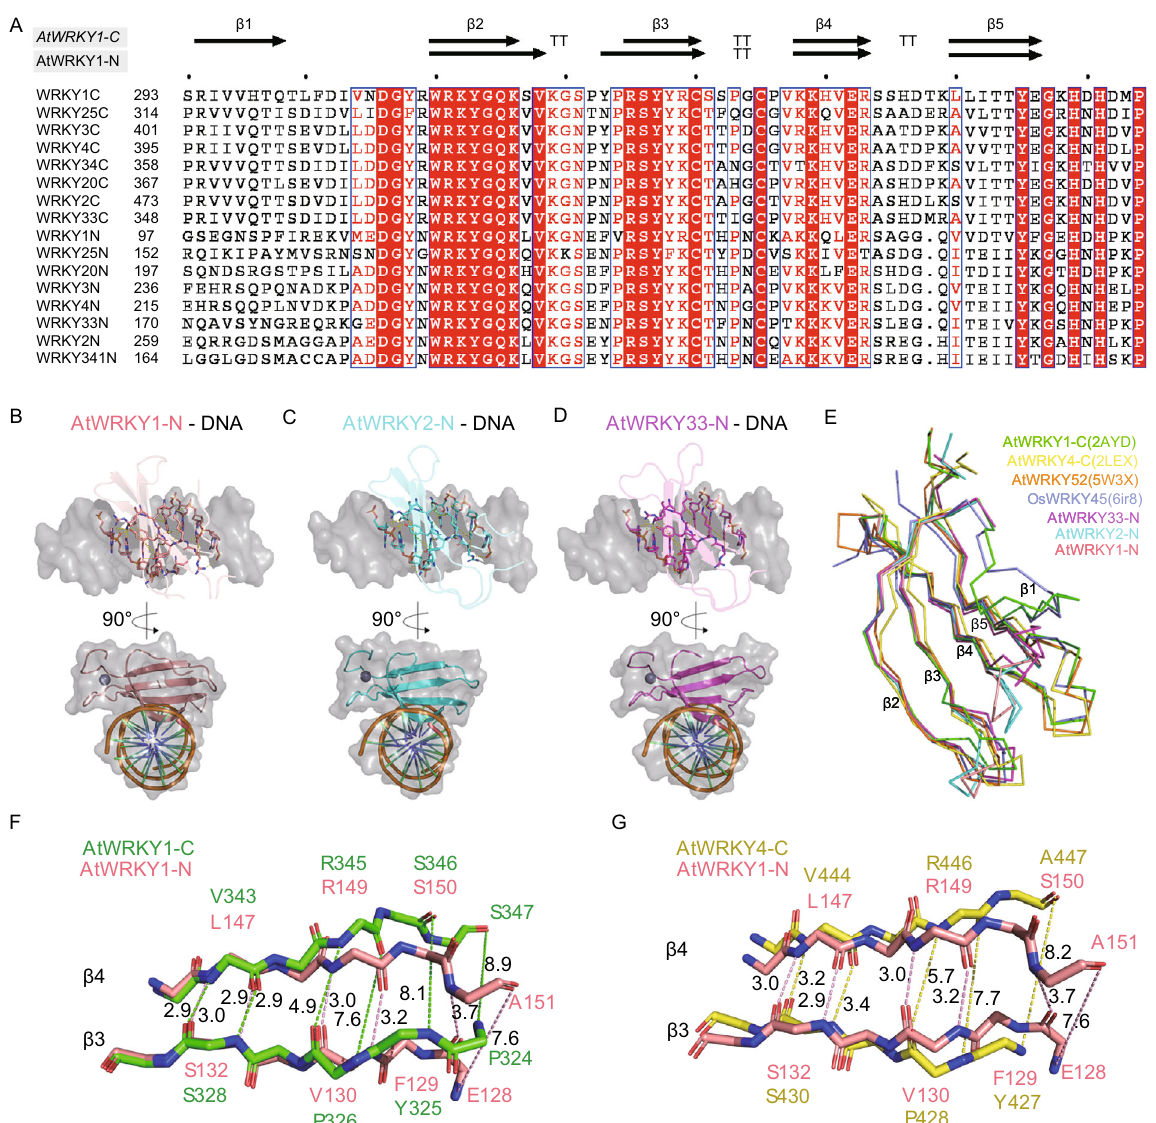
Figure 1. Overall properties and structures of N-terminal WRKY TFs . (A) Sequence alignments of DBDs of both the N-terminus and C-terminus of eight Arabidopsis WRKY proteins from group I based on the crystal structure of AtWRKY1-C (PDB code: 2AYD) (Duan et al., 2007) and AtWRKY1-N complexed with W-box DNA. Completely conserved residues are highlighted with red boxes, whereas less conserved residues are painted with different colors. (B – D) Overall structures of the N-terminal WRKY proteins (AtWRKY1-N, AtWRKY2-N and AtWRKY33-N) in complex with W-box DNA are shown in two orientations. The direct contacting residues with DNA are shown as sticks. (E) Structural comparison of three N-terminal WRKY proteins and other four WRKY domain structures. The loops between β 4 and β 5 strands with different conformations are circled by the gray background. (F and G) Distances of β 3 and β 4 of AtWRKY1-N are compared with those of AtWRKY1-C and AtWRKY4-C respectively. Their distances (Å) are shown next